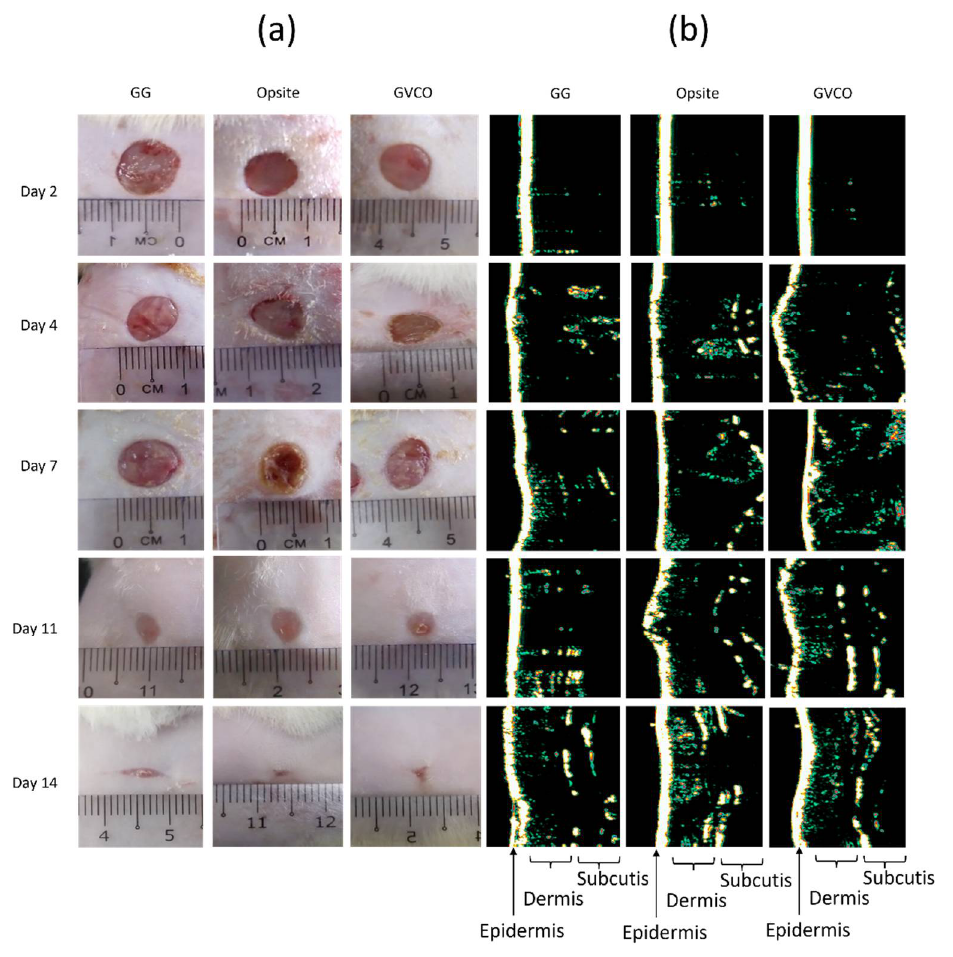
Figure 7. ( a ) Wound healing studies and ( b ) typical ultrasound images of wound skin on gellan gum (GG), Opsite, and GVCO80 hydrogels on days 2, 4, 7, 11, and 14. Hematoxylin and eosin (H & E) staining was performed to evaluate the quality of the wound tissue. Histological evaluation results show that the GVCO80 hydrogel resulted in better re-epithelization as compared to other samples (Figure 8). For Opsite and GVCO80 hydrogel, the formation of epithelial growth was observed and the number of inflammatory cells reduced. Meanwhile, in the control group (GG hydrogel), the new epithelium was noted to regenerate and a little scab was spotted and the necrotic tissue was found under defect. The skin treated with GVCO80 hydrogel and Opsite presented a better result than the control.